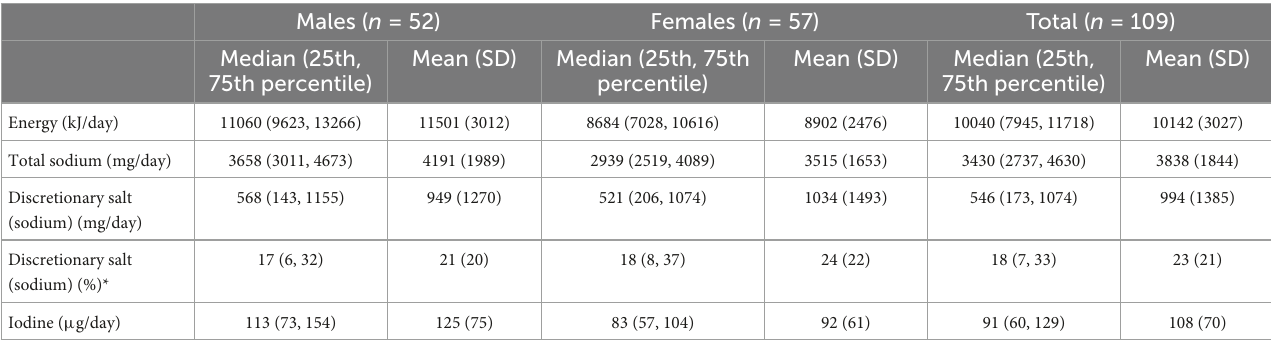
TABLE 3 Estimated intake of energy, total sodium, sodium intake from discretionary salt and iodine from 24-h dietary